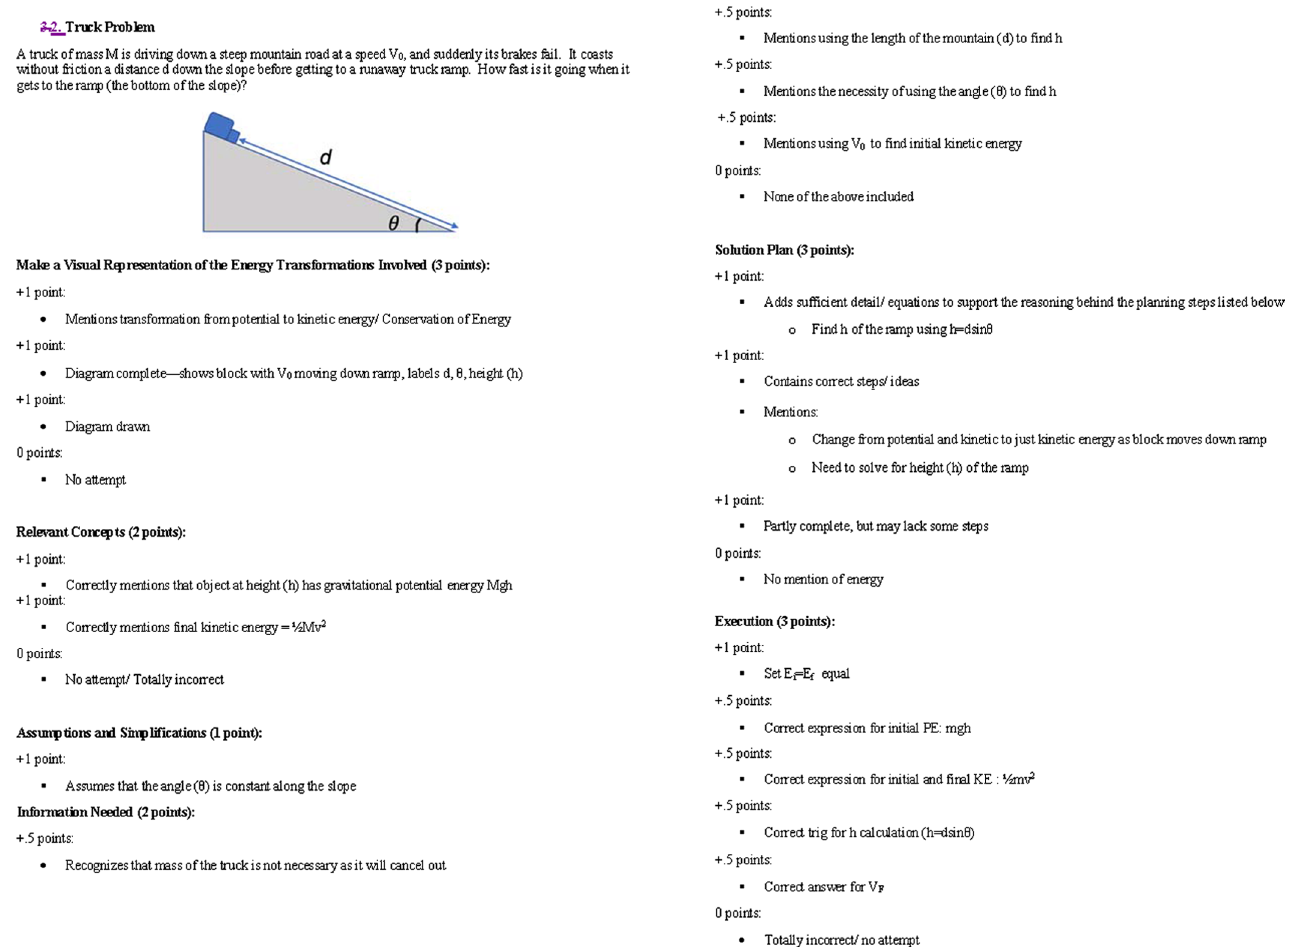
FIG. 8. Rubric for truck problem, part